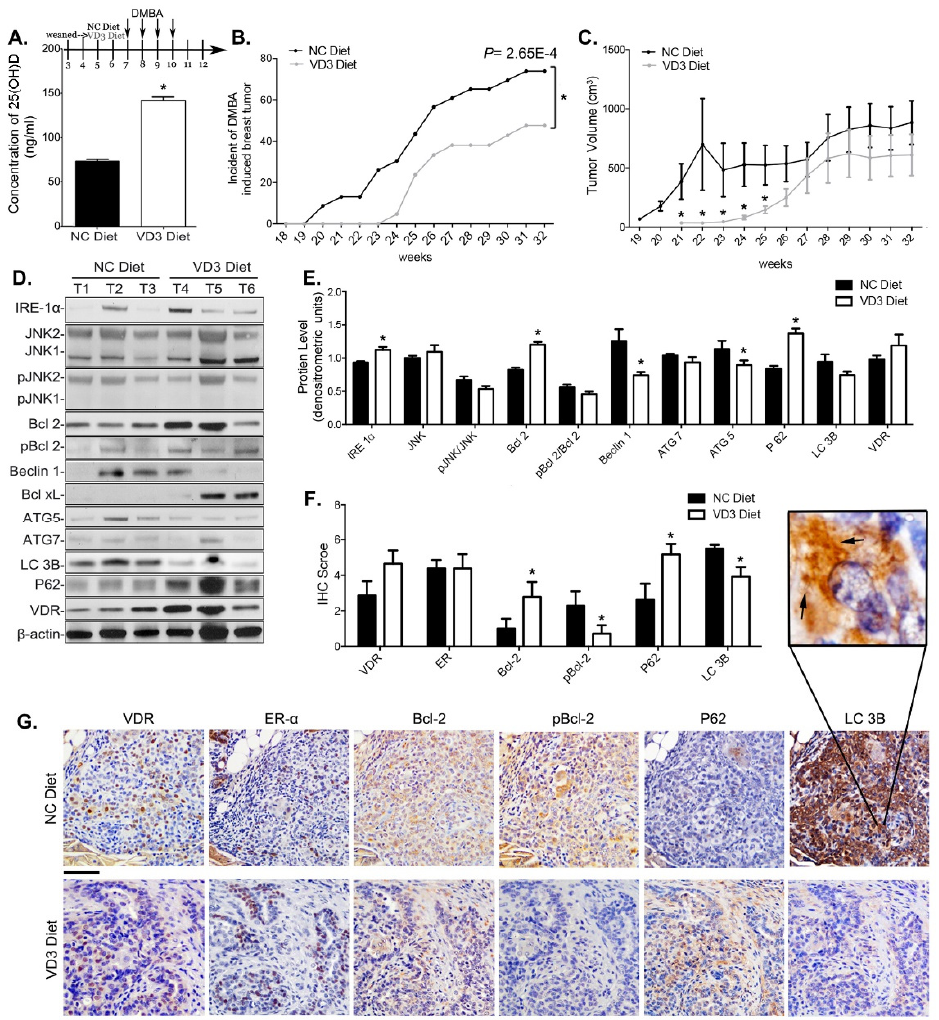
Figure 7. VD3 supplementation reduces mammary cancer risk and inhibits autophagy in mammary tumors. ( A ) Serum 25(OH)D concentration in mice fed AIN93G control diet containing 1K IU VD 3 (NC diet; n = 11) and VD3-supplemented AIN93G diet containing 20K IU VD 3 ( n = 11) for 8 weeks. Changes in ( B ) tumor incidence and ( C ) tumor burden (total tumor volume per mouse) in control ( n = 20) and VD 3 -supplemented diet ( n = 20) fed mice. ( D ) Western blot analyses of control ( n = 16) and VD 3 diet ( n = 16) fed mouse mammary tumors. (NC diet, n = 16; VD 3 diet, n = 16). 3 representative blots from each group are shown with β -actin as loading control. ( E ) Quantification of protein expression levels of the IRE1 α -JNK signaling pathway and autophagy. ( F ) Quantification of protein expression levels of VDR, ER- α , Bcl-2, pBcl-2, P62 and LC3B expression by IHC staining (NC diet, n = 8; VD 3 diet, n = 8). * p < 0.01. ( G ) Representative serial sections of tumor mass with IHC staining of VDR, ER- α , Bcl-2, pBcl-2, P62 and LC3B. Inset is 10 × , scale bar: 100 µ m. The IRE-1 α /UPR pathway and autophagy markers were measured in the ER+ tumors of VD 3 -supplemented mice. VD 3 supplementation increased IRE-1 α and Bcl-2 and reduced pBcl-2 protein levels in the mammary tumors (Figure 7D–G). Autophagy markers Beclin 1, Atg5, and LC3B were significantly reduced and p62 levels were increased (Figure 7D–G). Thus, dietary intake of VD 3 inhibited pro-survival autophagy markers and increased accumulation of p62, showing that autophagic flux was reduced in ER+ mammary tumors of mice supplemented with VD 3